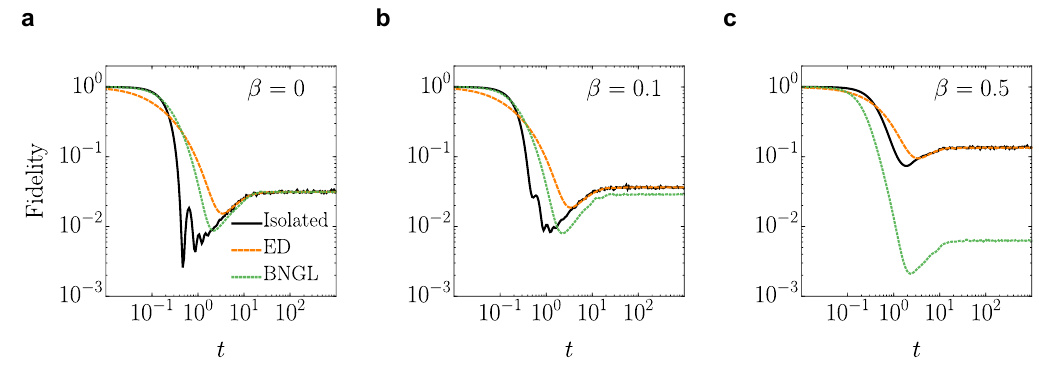
Figure 5 . Energy-Dephasing vs BNGL in Random Matrix Theory. The time-dependence of the fidelity between a coherent Gibbs state and its time evolution is compared for energy-dephasing (orange dashed line) and the nonlinear evolution for null-measurement conditioning associated with BNGL (green dotted line) with γ = 0 . 2 . For the sake of comparison, we also show the SFF of the corresponding isolated system (black solid line), γ = 0 . We consider a sample of 1000 independent Hamiltonians H 0 taken from GOE(2 5 ) . At long times, the fidelity reaches a plateau with the value h Z (2 β ) /Z 2 ( β ) i for γ = 0 and h 1 /Z ( β ) i for γ 6 = 0